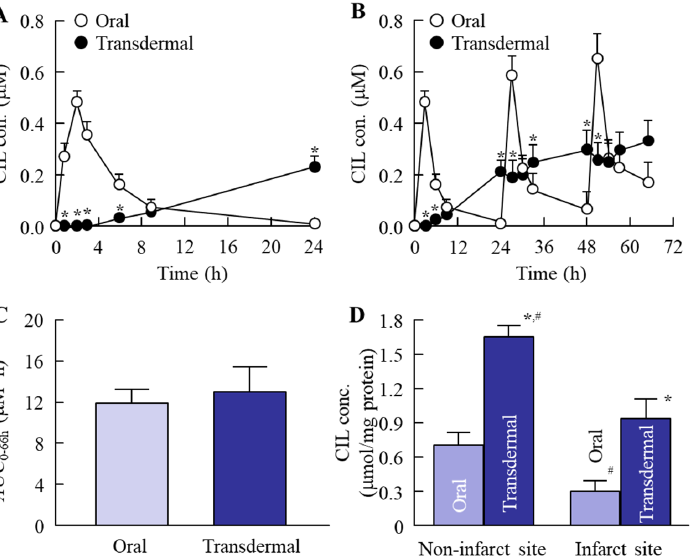
Figure 6. The percutaneous absorption of the CIL-Ngel. ( A ) Plasma CIL concentration in rats following a single oral or transdermal administration of CIL. ( B , C ) Plasma CIL concentration ( B ) and AUC 0–66h ( C ) in rats following repetitive oral or transdermal administration of CIL. ( D ) CIL concentration in brain of middle cerebral artery occlusion (MCAO)/reperfusion model mice after the oral and transdermal administration of CIL. The administration of CIL was per- formed once a day for 3 days in the repetitive administration. Oral, group orally treated with CIL powder; transdermal, group transdermally treated with CIL-Ngel. n = 5–8. * p < 0.05 vs. CIL orally treated group for each category, # p < 0.05 vs. infarct site of MCAO/reperfusion model mice transdermally treated with CIL for each category. The percutaneous absorption of CIL from the CIL-Ngel increased linearly for 24 h, and CIL was delivered to the brain following administration of the CIL-Ngel. Although the AUC 0–66h with the CIL-Ngel was similar to that following the oral administration of CIL macroparticles (CIL-MPs), the CIL content was higher than that in the mice treated with CIL